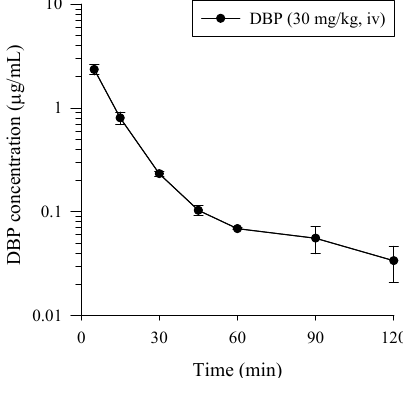
Figure 4. Concentration versus time curve in rat plasma after DBP (30 mg/kg, i.v.) administration. Data are presented as mean ± SEM ( n =